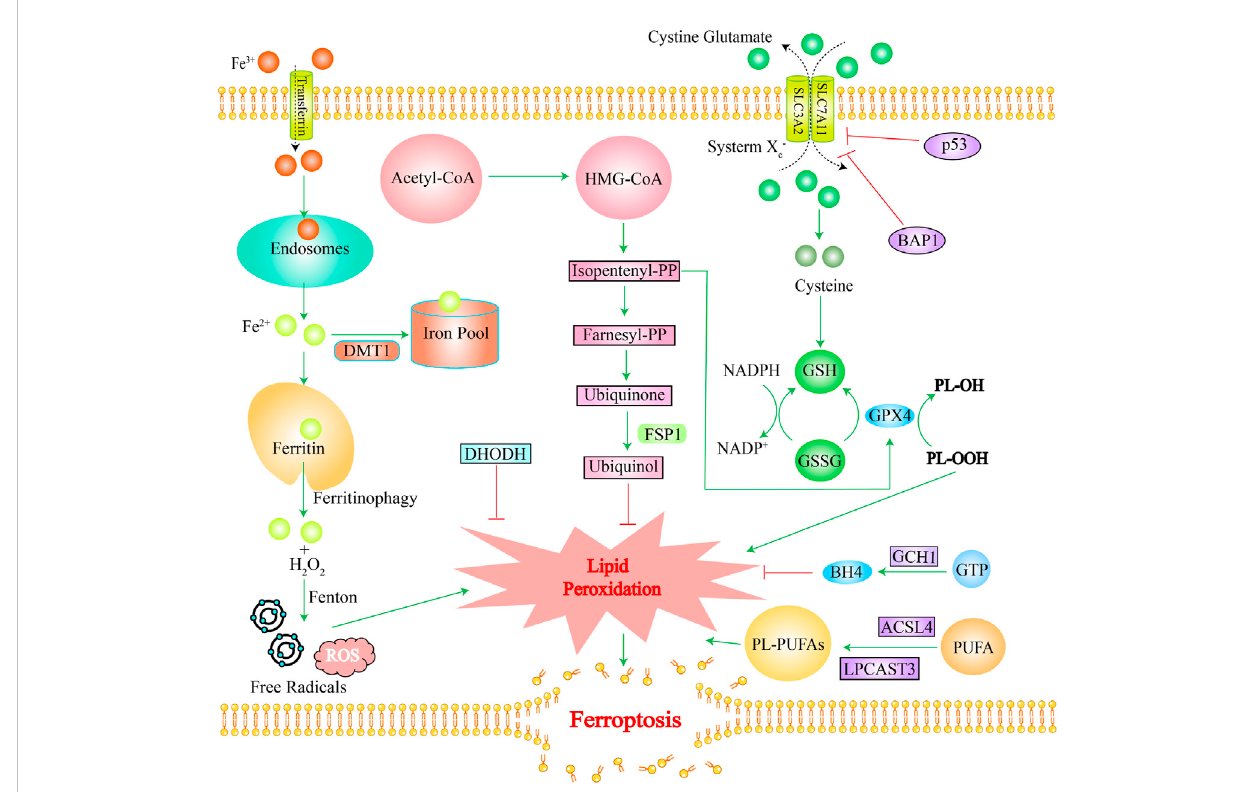
FIGURE 1 The main mechanism of ferroptosis. Green lines stand for promotion effects and red lines stand for inhibition effects. Iron overload, ROS accumulation, and lipid peroxidation induce ferroptosis. The GPX4 pathway, FS1-Ubiquinol pathway, GCH1-BH4 pathway, and DHODH pathway inhibit ferroptosis. Ferritin releases Fe 2+ via “ ferritinophagy ” which initiates a Fenton reaction with H 2 O 2 produced, generating excessive ROS and free radicals. DHODH detoxi fi es lipid peroxides and inhibits ferroptosis. FSP1 converts Ubiquinone into Ubiquinol, thereby inhibiting lipid peroxidation. GPX4requiresGSHasacofactortopromoteinhibitionoflipidperoxidation.ThesystemXc — exchangescystineandglutamicacid,whichareconvertedto cysteineforglutathionesynthesis.BAPIandp53genescaninhibitcystineuptakebyinhibitingtheexpressionofSLC7A11.GCH1catalyzesGTPtoproduce BH4, reshaping lipids to inhibit ferroptosis. ACSL4 and LPCAT3 are necessary for production of PL-PUFAs, which promote ferroptosis. Abbreviation: DMT1, divalent metal transporter 1; Acetyl-CoA, Acetyl-coenzyme A; FSP1, ferroptosis suppressor protein 1; BAP1, BRCA1 associated protein 1; GSH, glutathione; GSSG, Oxidized glutathione; BH4, Tetrahydrobiopterin; GCH1, GTP cyclohydrolase-1; DHODH, dihydrolactate dehydrogenase; GTP, guanosine triphosphate cyclohydrolase-1; ACSL4, long-chain fatty acyl-CoA; LPCAST3, lysolecithin acyltransferase 3; HMG-CoA, 3-Hydroxy-3-Methyl- Glutaryl-CoA; PP,